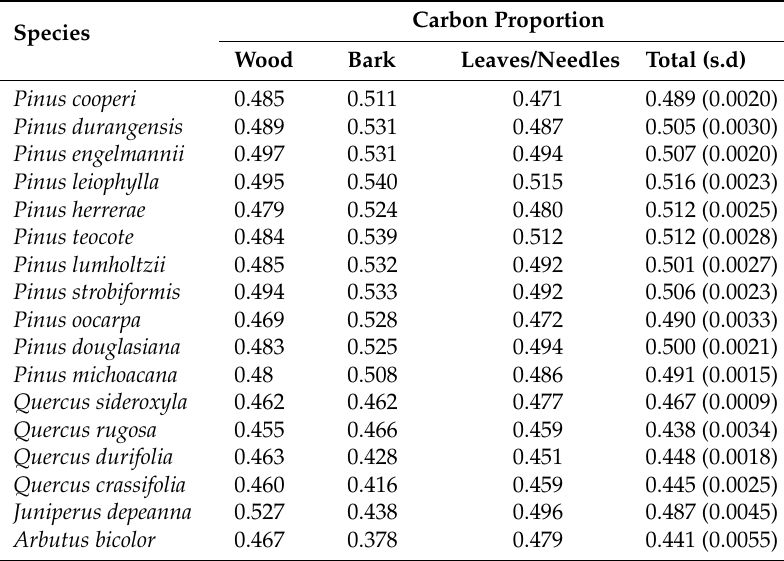
Table 3. Specific mean carbon contents of the main tree components of pine and oak species in the study (standard deviation is given in brackets).